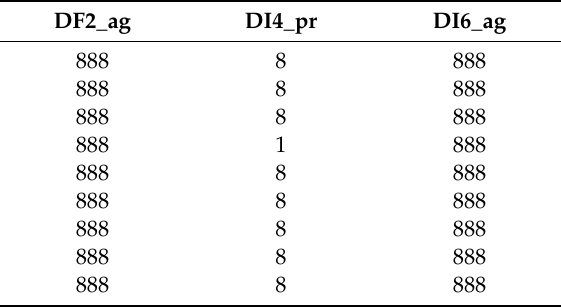
Table 2. Data construct. DF2_ag, time of depression diagnosis; DI6_ag, time of angina pectoris diagnosis; DI4_pr, presence or absence of comorbidities of myocardial infarction and angina